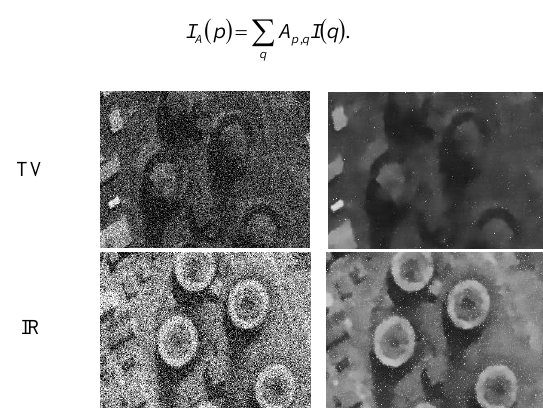
Figure 1. Examples of diffusion filtering for denoising of TV and IR